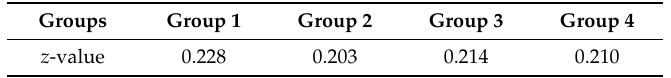
Table 14. S tatistical parameters for reliability assessment of samples. Table 15. Design values ( z ) for testing lab groups (obtained from Equation (17)).